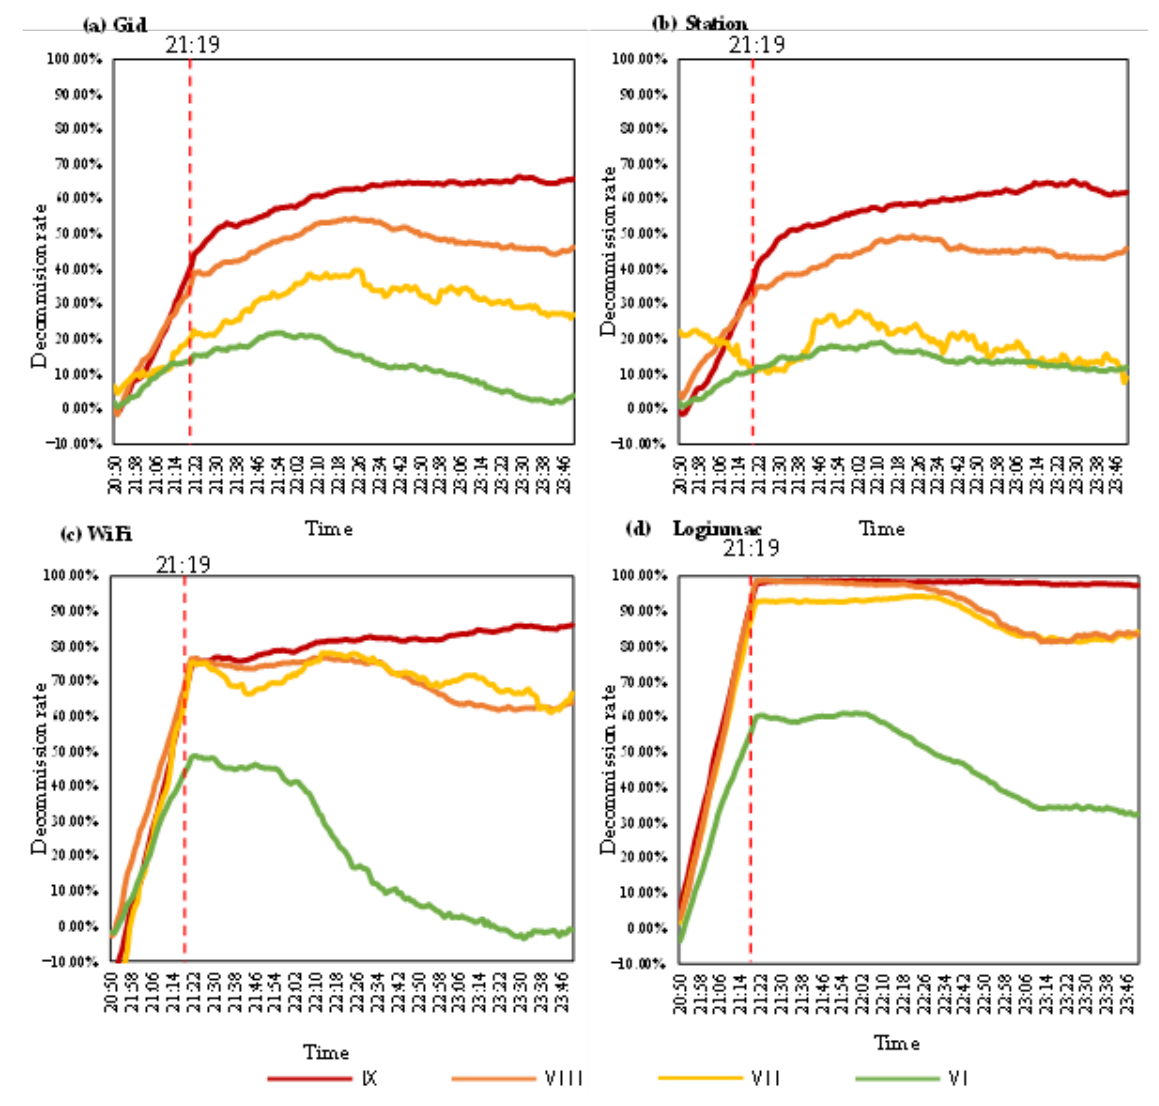
Figure 5. The 30-min moving average variation of decommission rate in different intensity zones for the four types of mobile signaling.